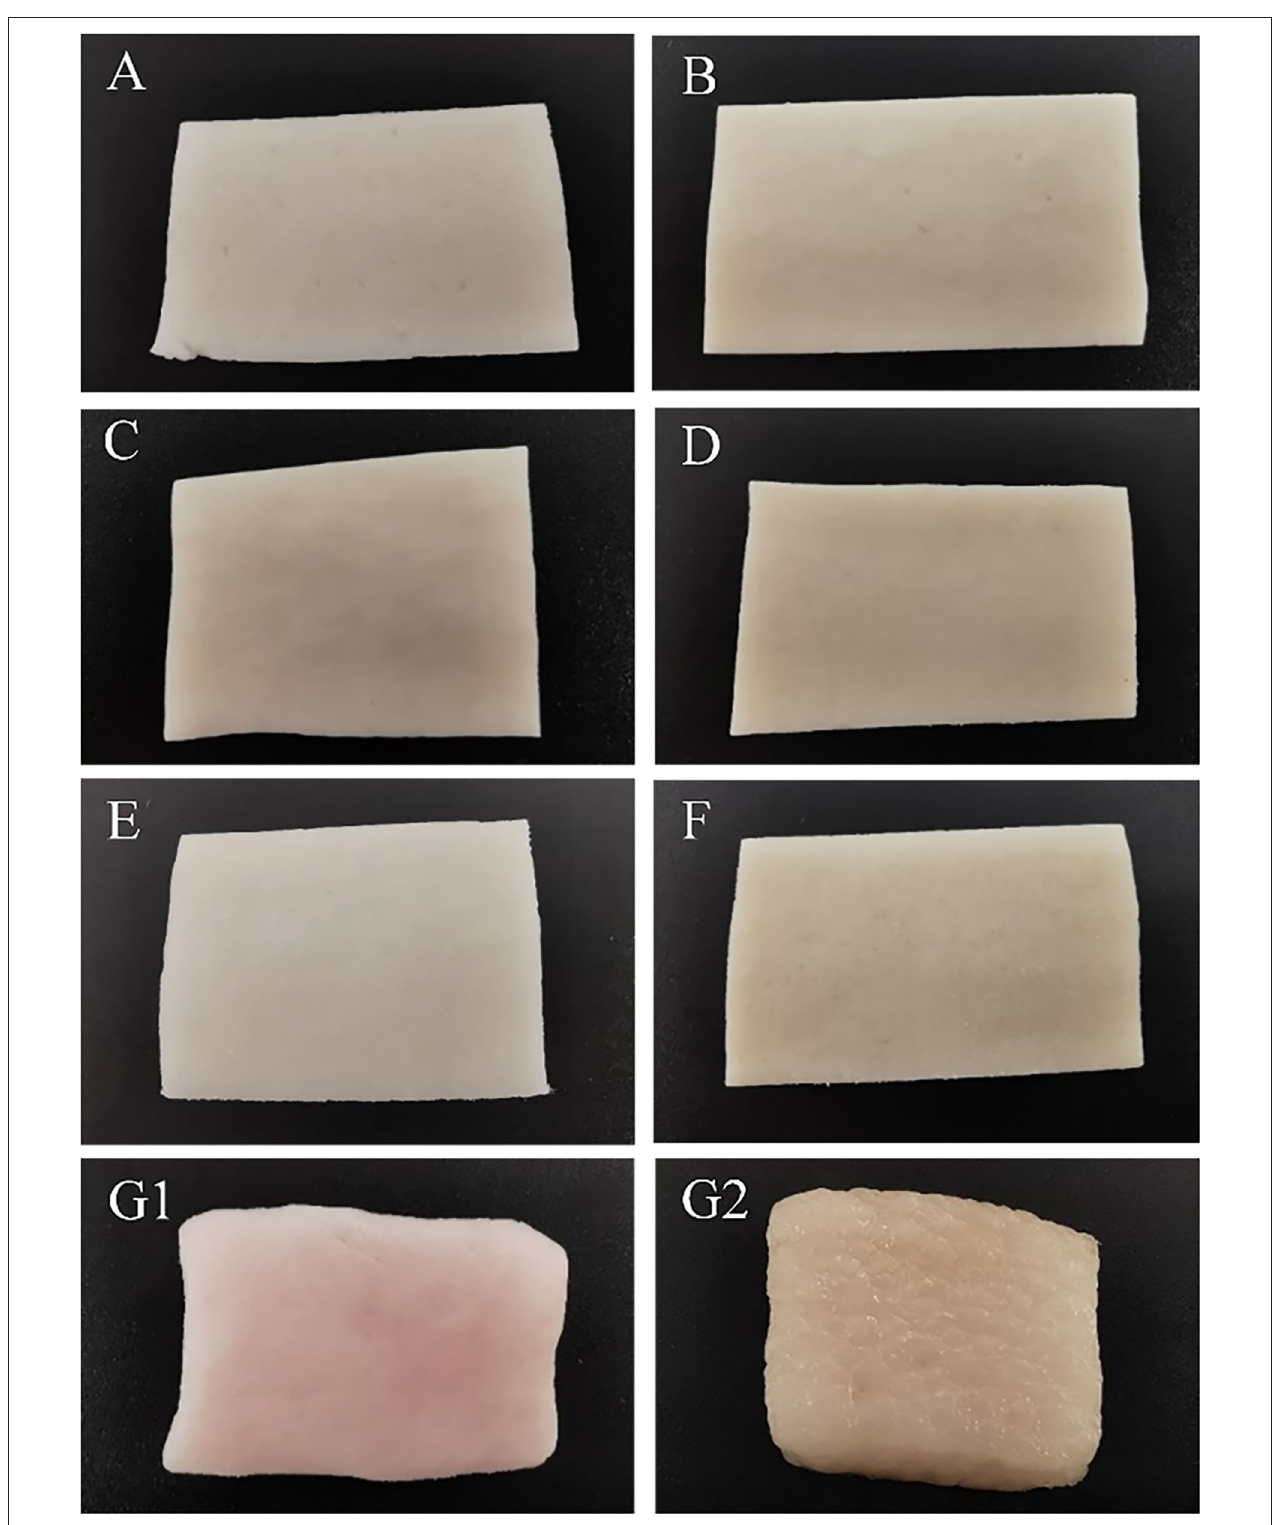
FIGURE 3 | Photographic images of samples with different protein content and konjac content. (A) S1K2; (B) S5K2; (C) S2K4; (D) S5K4; (E) S1K6; (F) S5K6; (G1) pork fat; (G2) pork fat (cook for 20min).